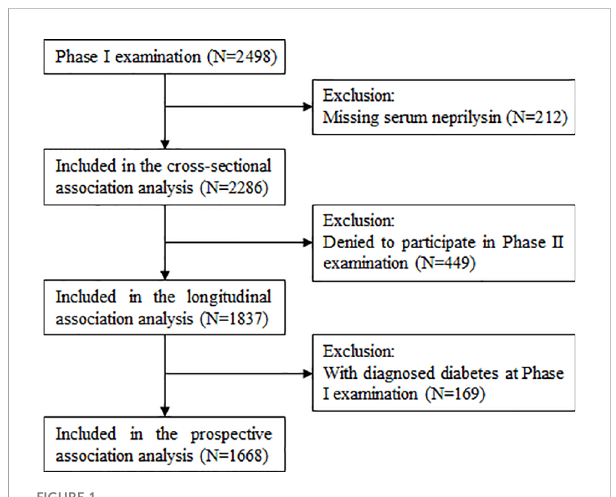
FIGURE 1 A fl owchart illustrating the selection of participants and analytical